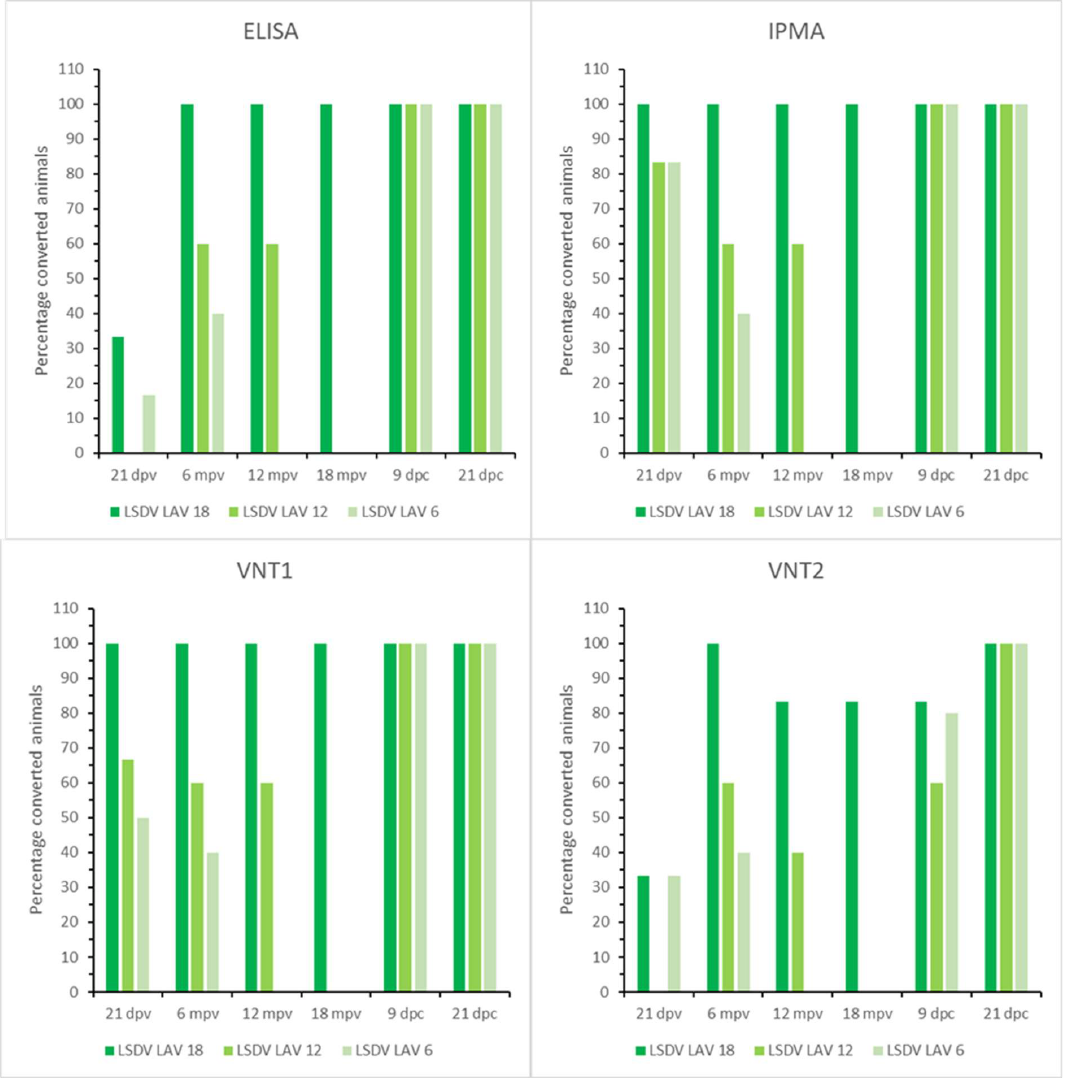
Figure 4. ELISA, IPMA, VNT1 and VNT2 results of the LSDV LAV groups; mpv: months post-